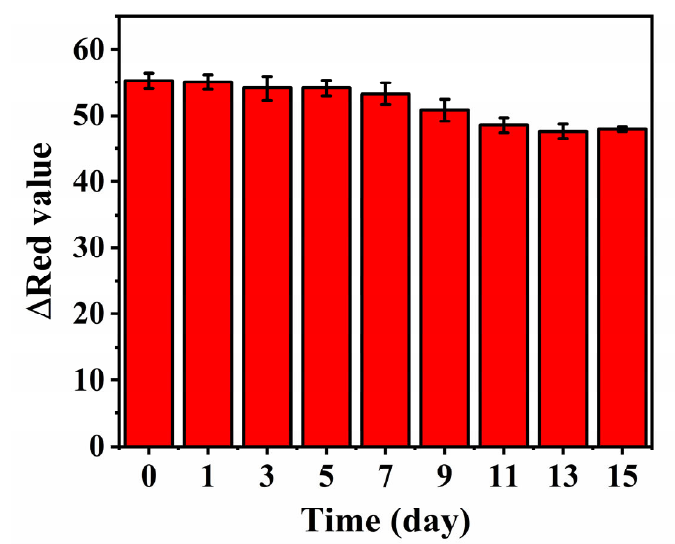
Figure 7. Storage stability of the paper device in a refrigerator at 4 °C.